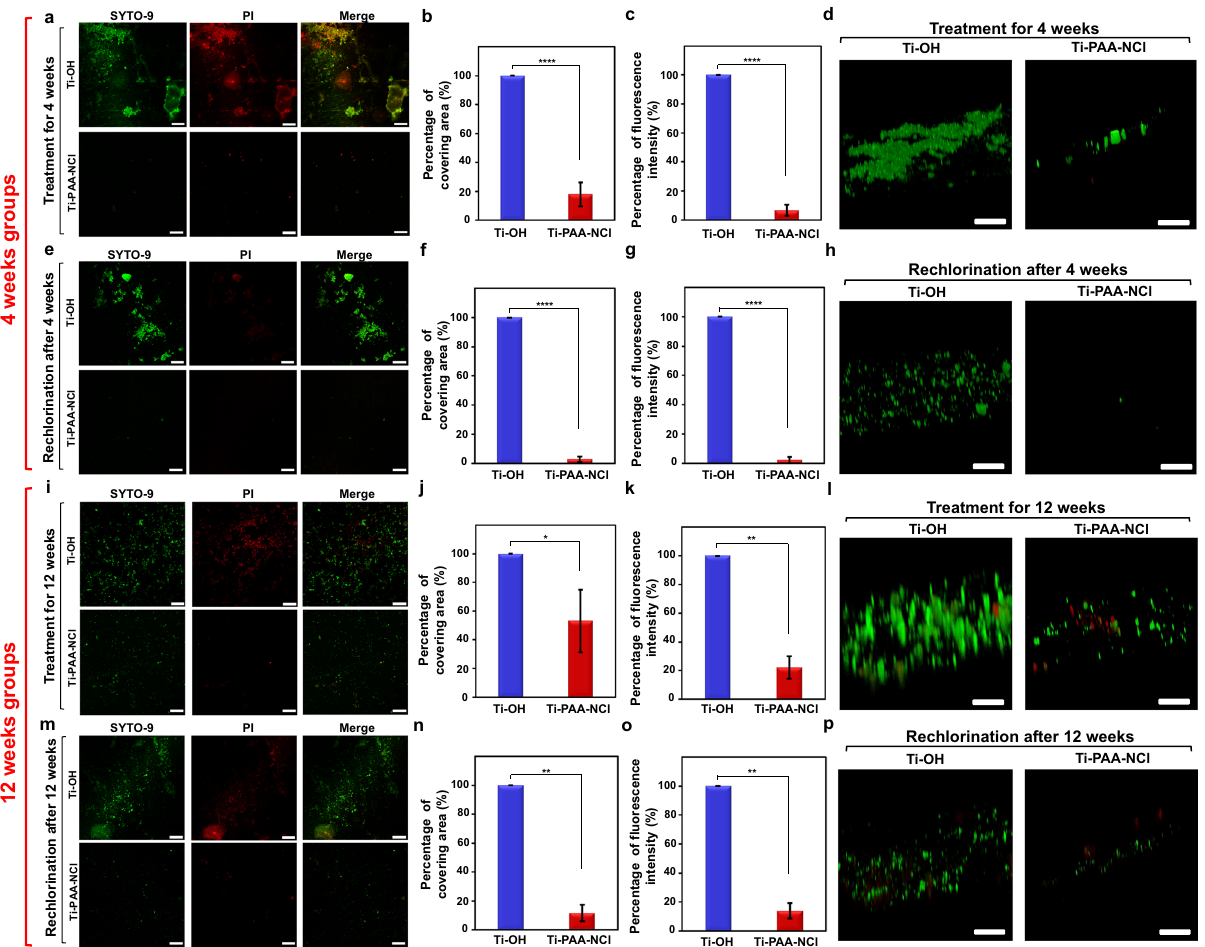
Fig. 7 Intraoral assessment of the long-lasting and renewable antibacterial effect against human bacterial colonies. a Fluorescent staining of bacteria on Ti-OH and Ti-PAA-NCl after treatment in the complex environment of the real oral cavity for 4 weeks. b , c Percentages of b covering area and c fl uorescence intensity of bacteria on Ti-OH and Ti-PAA-NCl after treatment for 4 weeks. d 3D morphology of the fl uorescently stained bio fi lms on Ti-PAA- NCl and Ti-OH after treatment for 4 weeks. e – p Fluorescent staining, quantitative analysis and bio fi lm morphology of bacteria on Ti-PAA-NCl and Ti-OH e – h after treatment for 4 weeks and rechlorination, i – l after treatment for 12 weeks and m – p after treatment for 12 weeks and rechlorination. Green for live bacteria and red for dead bacteria; scale bars in a , e , i , m = 50 μ m, scale bars in d , h , l , p = 20 μ m; n in a – h = 8, n in i – p = 3. * P < 0.05, ** P < 0.001 and **** P < 0.0001; Student ’ s t test; all error bars =